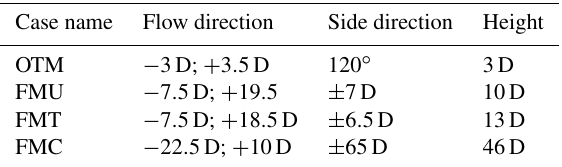
Table 2. Background dimensions in rotor diameters from the tower bottom. Values are approximated and referred to the tower